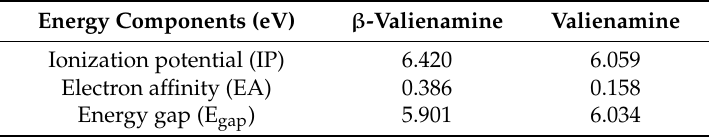
Table 1. E gap , IP, EA energies between the β -valienamine and